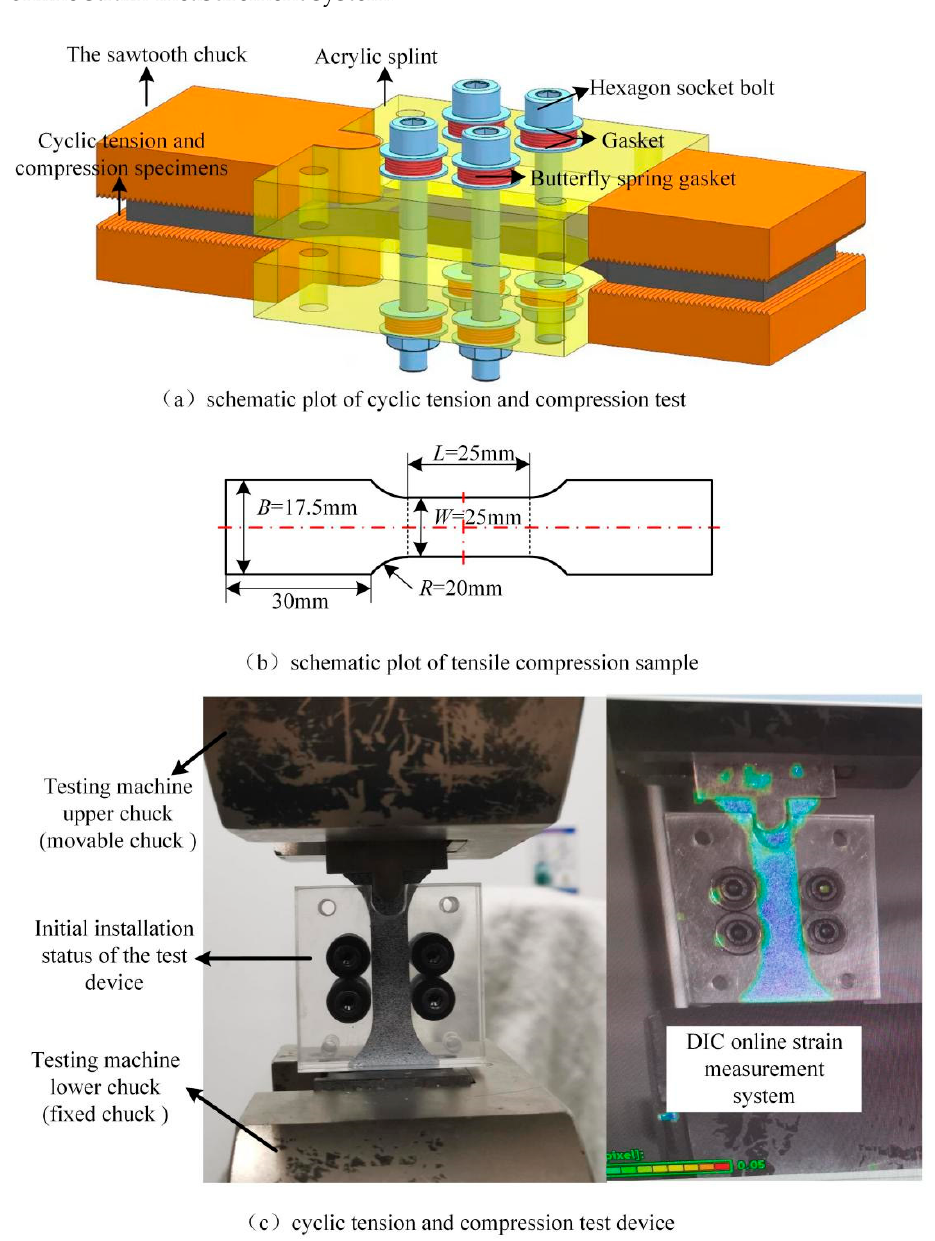
Figure 9. Cyclic tensile–compression test: ( a ) schematic diagram of cyclic tension and compression test; ( b ) schematic drawing of used tensile–compression specimen; ( c ) cyclic tension and compression test device.